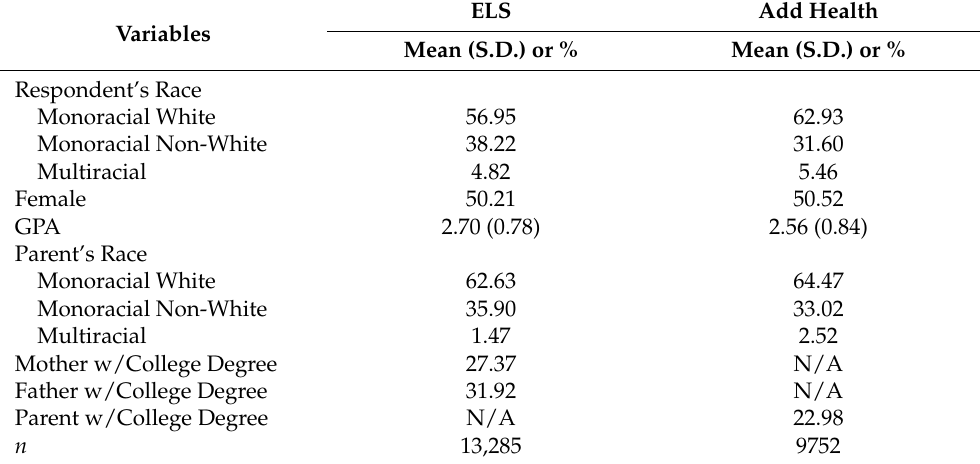
Table 1. Descriptive Statistics for